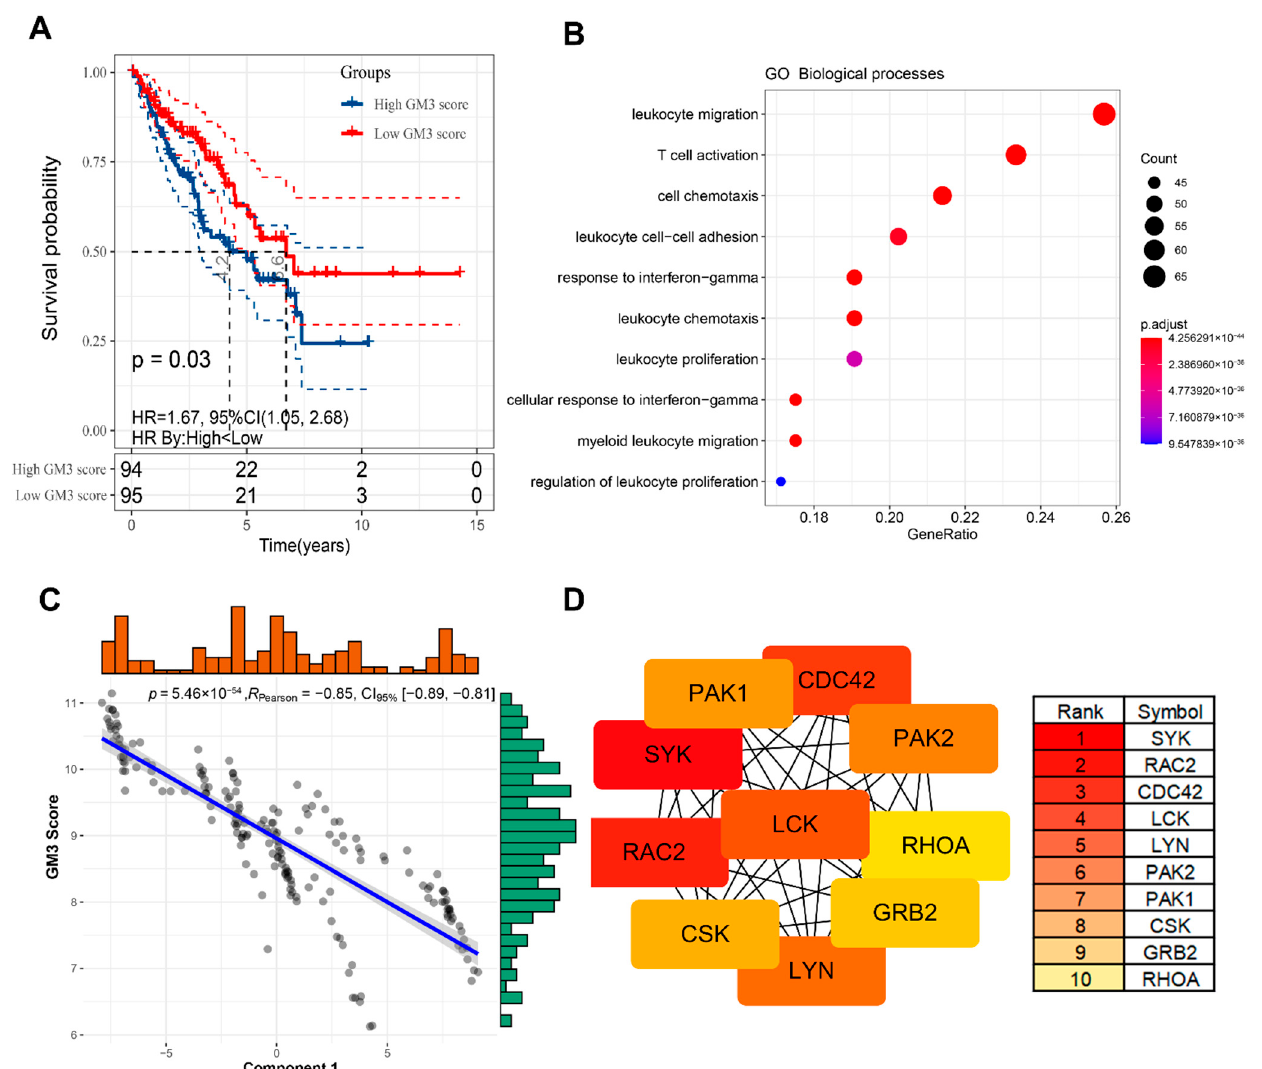
Figure 8. GM3 characteristics and immune hub genes. ( A ) Kaplan–Meier curve showing OS analysis of GM3 in STS. ( B ) GO biological process enrichment analysis of GM3. ( C ) Correlation between GM3 score and principal component 1 in the immune landscape. ( D ) Top 10 hub genes in GM3.